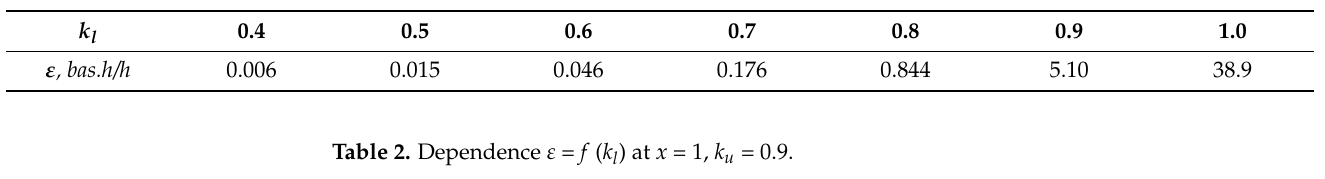
Figure 8. Dependence ε = f ( k l ) at х = − 1. Table 1. Dependence ε = f ( k l ) at x = 0, k u = 0.9.